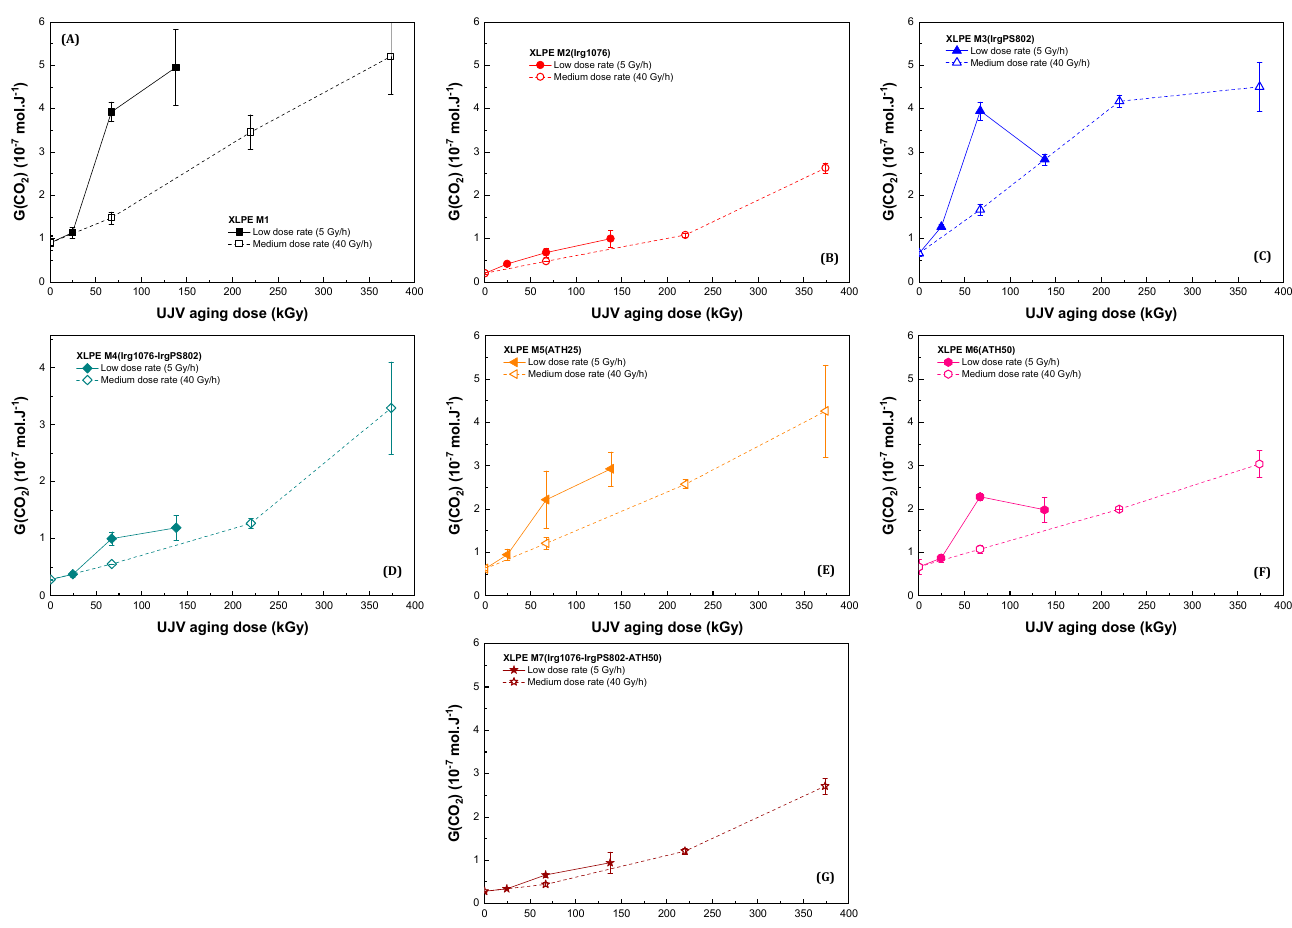
Figure 5. Carbon dioxide emission radiation chemical yields evolution as a function of dose at two different dose rates (open symbols for 5 Gy · h − 1 and solid symbols for 40 Gy · h − 1 ), for ( A ) XLPE M1, ( B ) XLPE M2(Irg1076), ( C ) XLPE M3(IrgPS802), ( D ) XLPE M4(Irg1076-IrgPS802), ( E ) XLPE M5(ATH25), ( F ) XLPE M6(ATH50), and ( G ) XLPE M7(Irg1076- IrgPS802-ATH50).